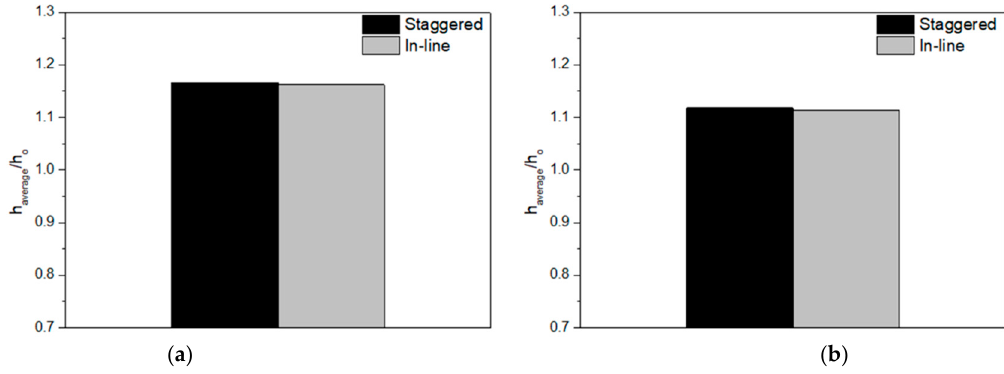
Table 3. Velocity and momentum ratios for various coolant injection